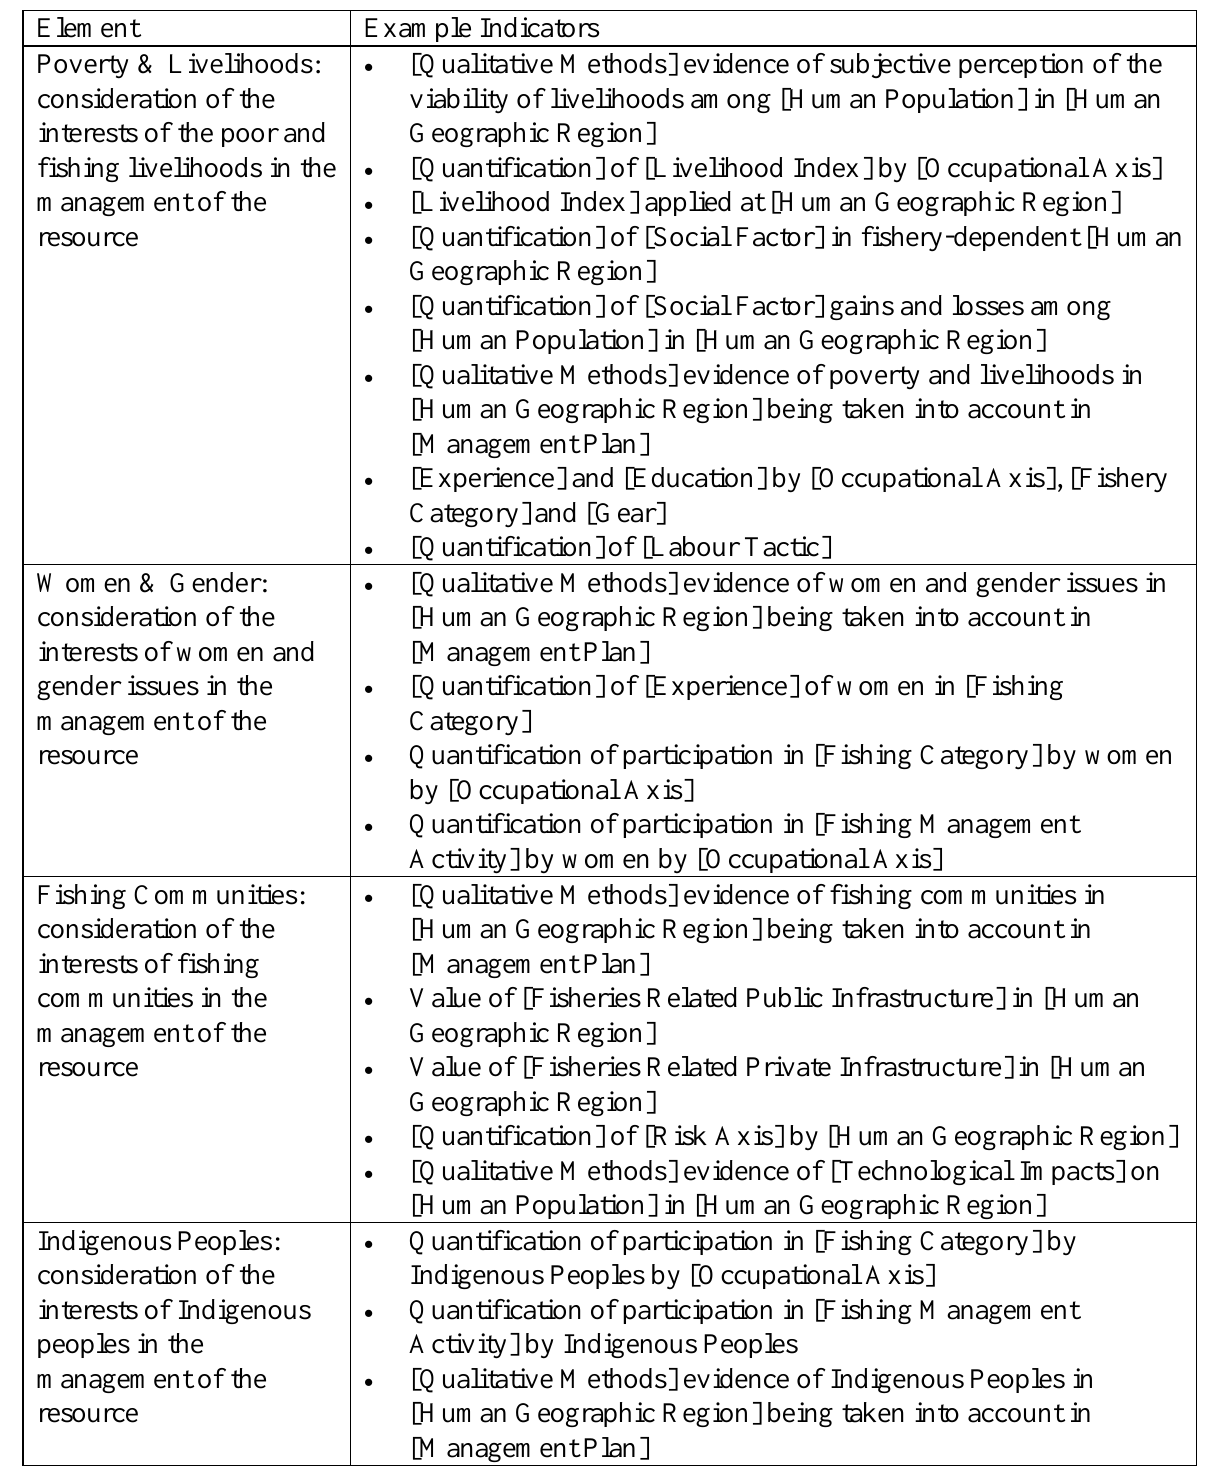
Table A1.9: Social Justice Dimension – Example Indicators Element Example